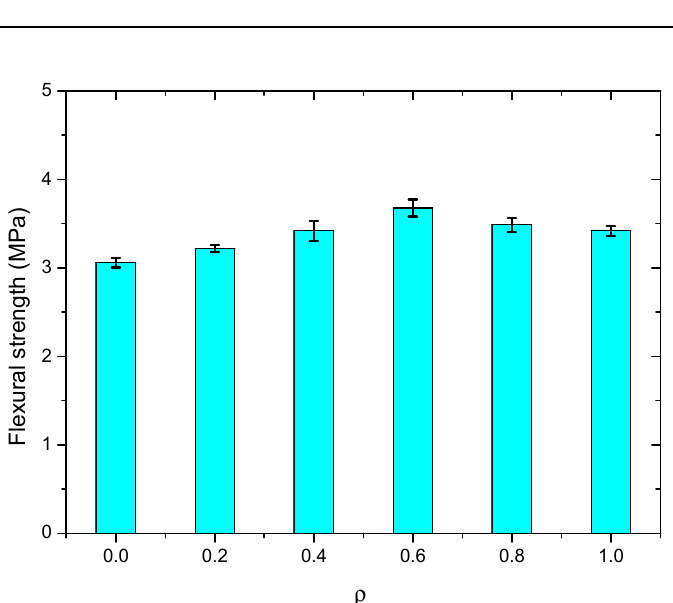
Figure 22. f f of SWSSC specimens with different ρ .